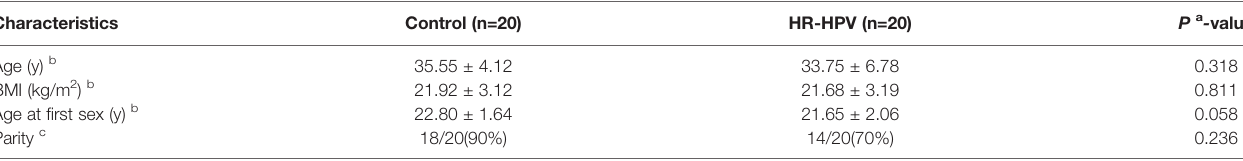
TABLE 1 | Characteristics of subjects in the control and HR-HPV